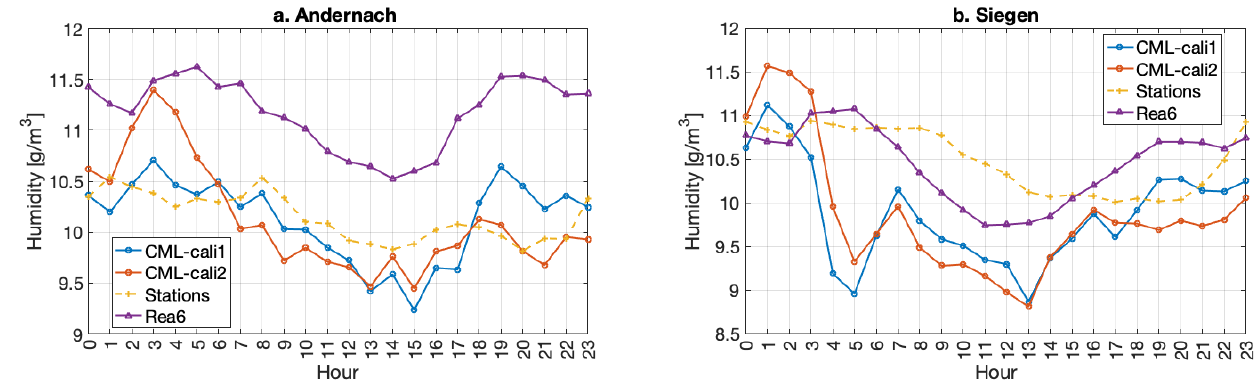
Figure 4. Diurnal CML-HO (CML-cali1/2), WS-HO (Stations), and Rea6 for two stations with a different CML-HO behavior. ( a ) A station with high humidity values at night, as observed at the WS, that gradually decrease until the morning. At this station, there is no significant decrease at night, and a similar pattern to the Rea6 is observed during the day. ( b ) A station with low CML-HO values as compared to WS-HO at night. The same calibration equation for all hours was applied (red, cali2). Rea6 is yellow and WS-HO is purple.